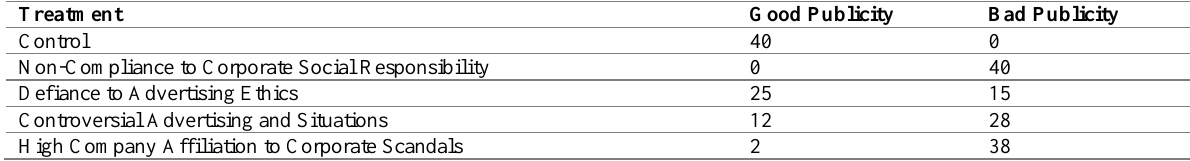
Table 1: Responses of Subjects to Different Treatments